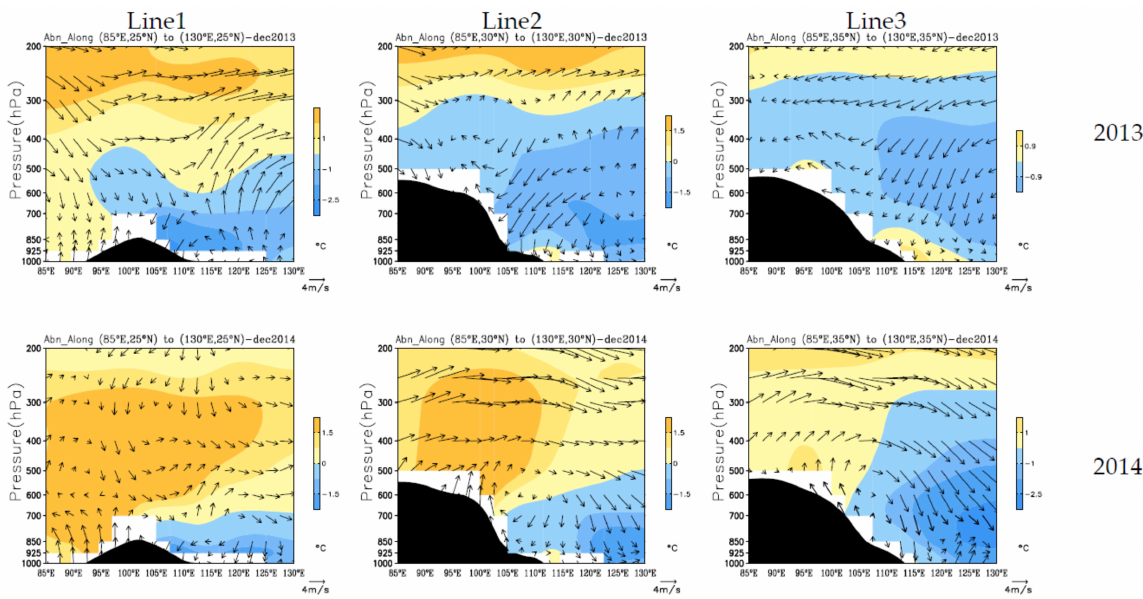
Figure 5. Schematic diagram of cross sections along east–west (LINE1–3) and south–north (LINE4– 6) directions.